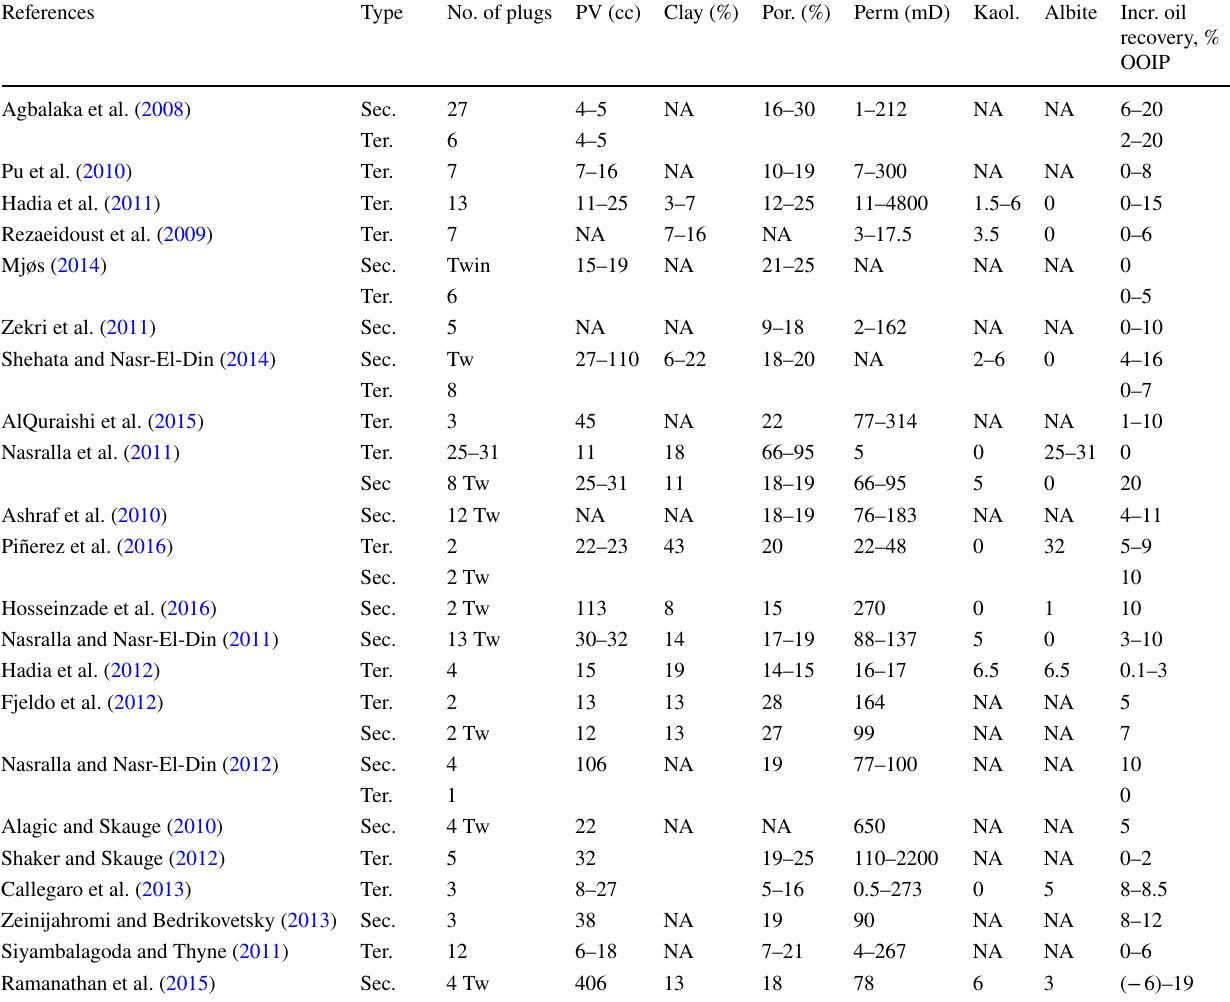
Table 1 Summary of core-flood experiments results collected from the